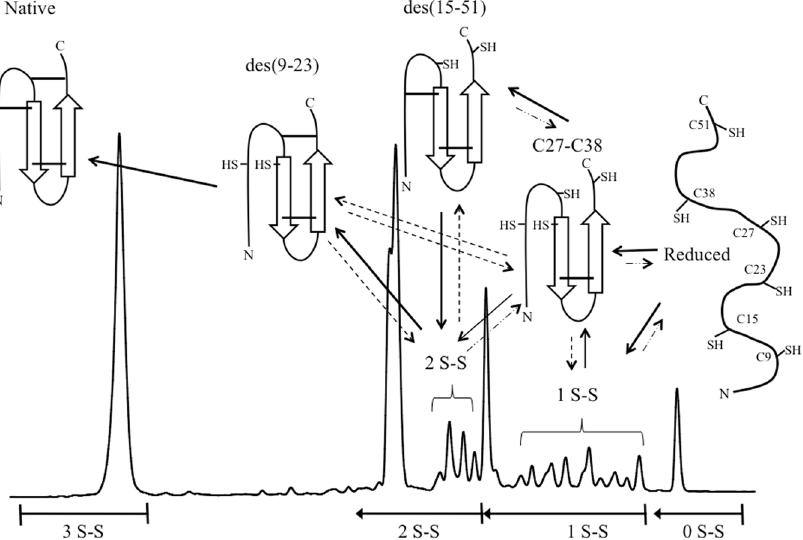
Figure 10. Schematic representation of the disulfide oxidative folding pathway of NvCI. The polypeptide backbone and the β -sheets of the protein are depicted by lines and arrows, respectively. The positions of the six cysteine residues are indicated (SH: 9, 15, 23, 27, 38 and 51) and the disulfide bonds are depicted as solid lines. The RP-HPLC chromatogram and the major disulfide intermediates are depicted and the disulfide bond content of all the RP-HPLC fractions are indicated below the graph. The solid lines represent the productive disulfide folding pathway